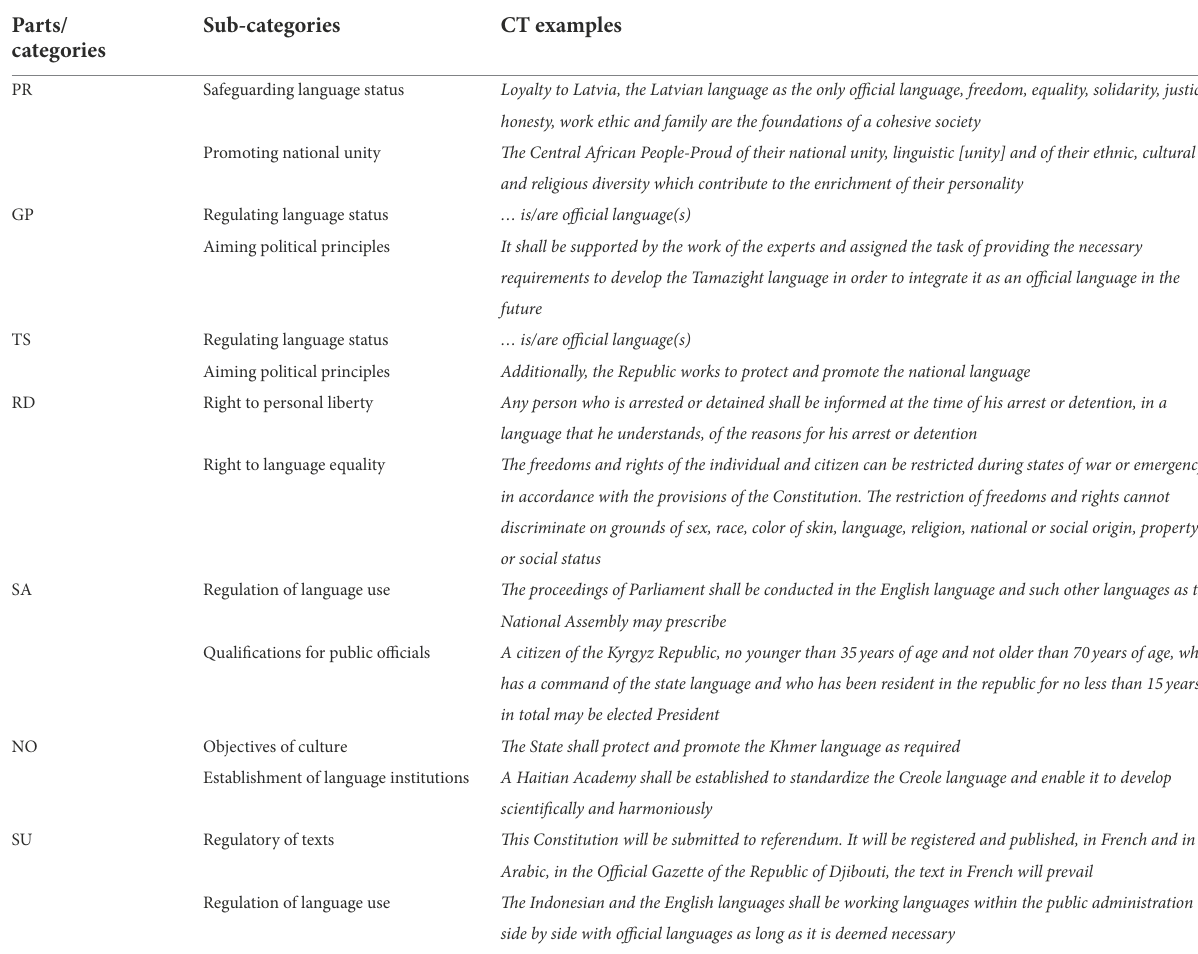
TABLE 1 Examples of language provisions coded into seven parts.